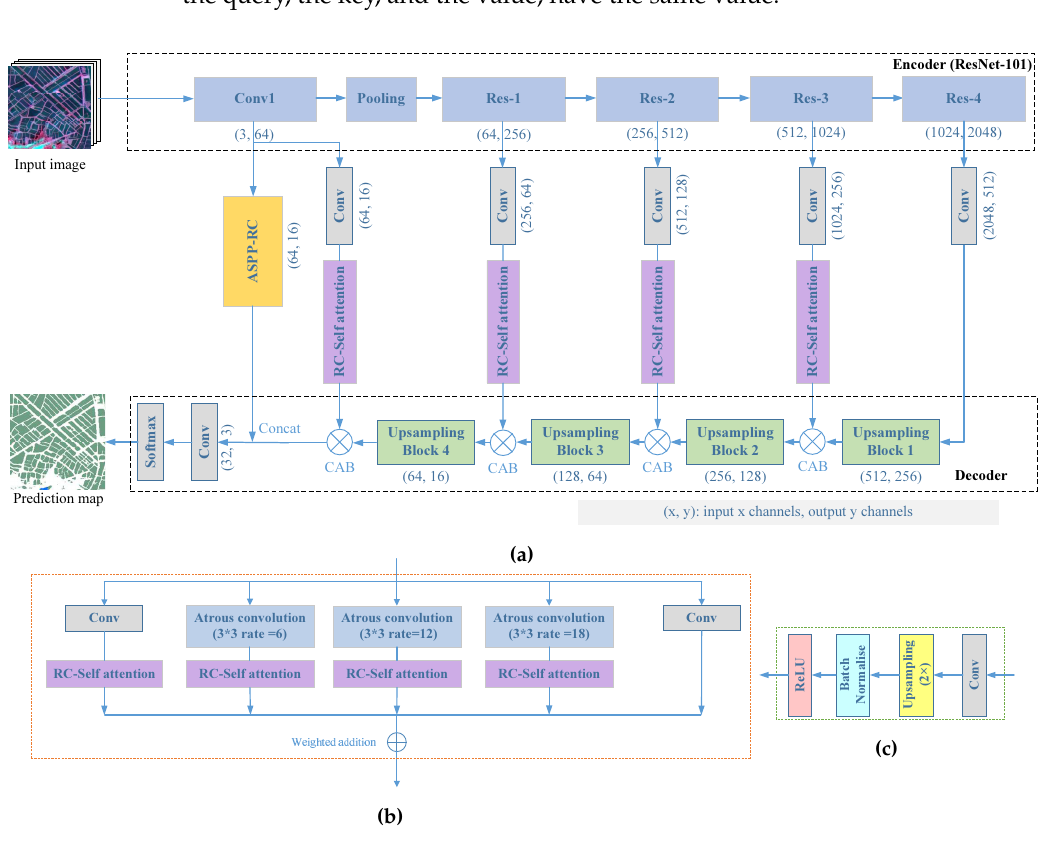
Figure 3. RCSANet: FCN architecture combined with RCSA mechanism for semantic segmentation of aquaculture ponds: ( a ) Network architecture; ( b ) ASPP-RC module; ( c ) Upsampling block. The input image of the entire deep neural network is a 256 × 256 pansharpening patch with three spectral channels. Through encoding and decoding, a three-channel matrix for classification was output through a 1 × 1 convolution layer at the end, and finally a Softmax layer gave a prediction map with the same size as the input image.